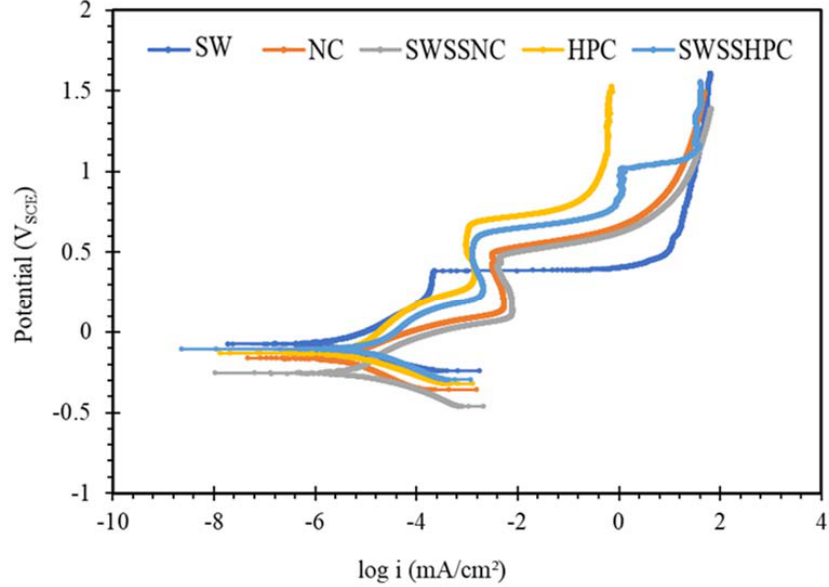
Figure 7. Polarization curves obtained for SS304 steel exposed to SW, NC, SWSSNC, HPC and SWSSHPC solutions for 168 h.